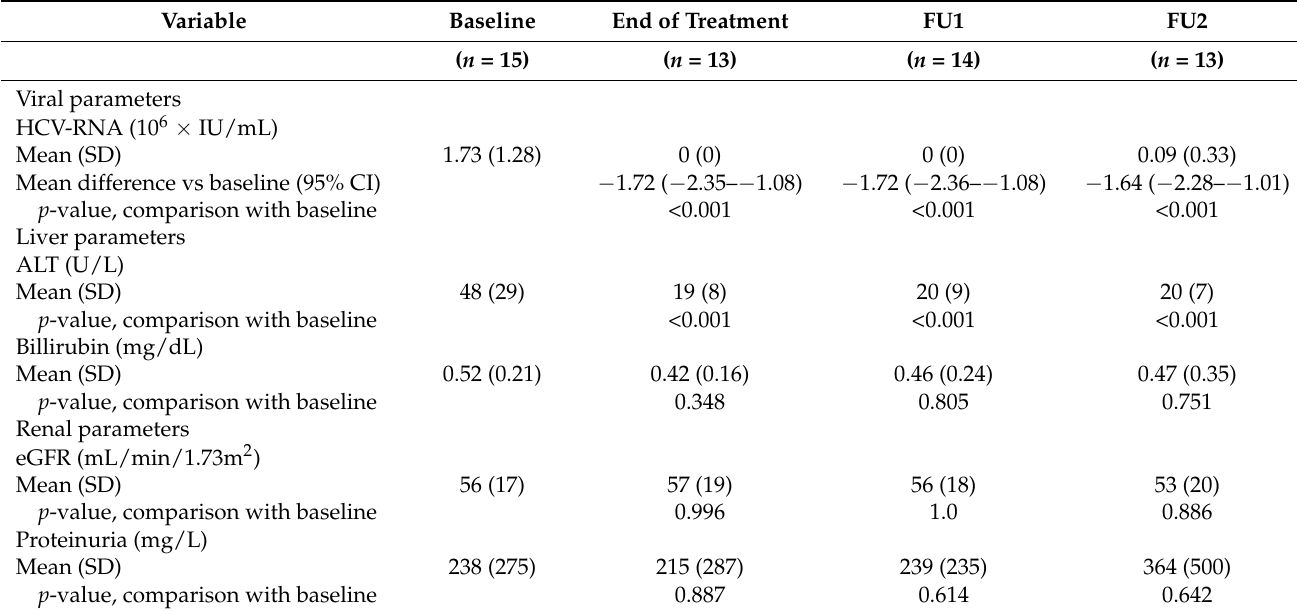
Table 2. Laboratory